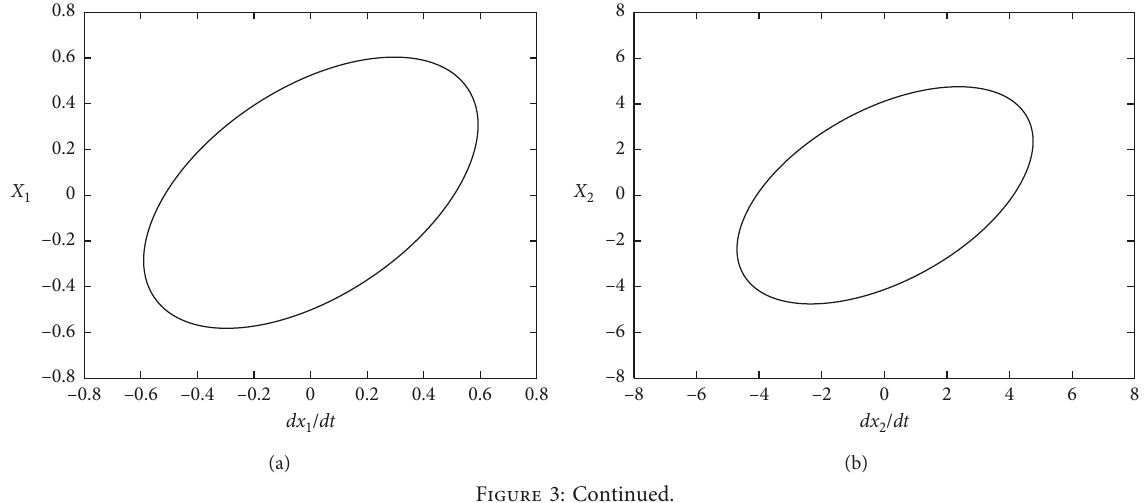
Figure 2: Vibration characteristics of hull dynamic system for ω diagram in x 2 direction. (c) Poincar´e map in x 1 direction. (d) Poincar´e map in x 2